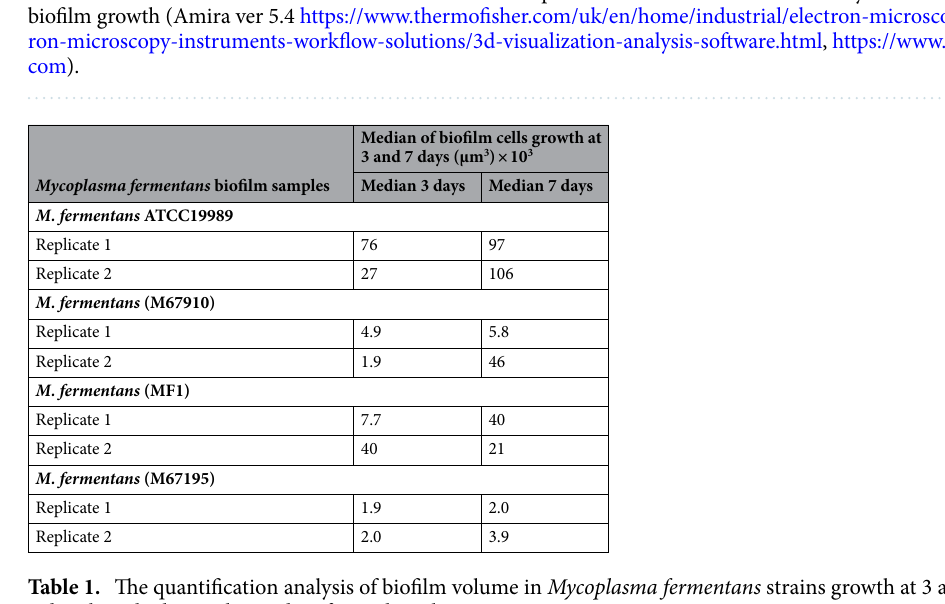
Table 1. The quantification analysis of biofilm volume in Mycoplasma fermentans strains growth at 3 and 7 days by calculating the median for each